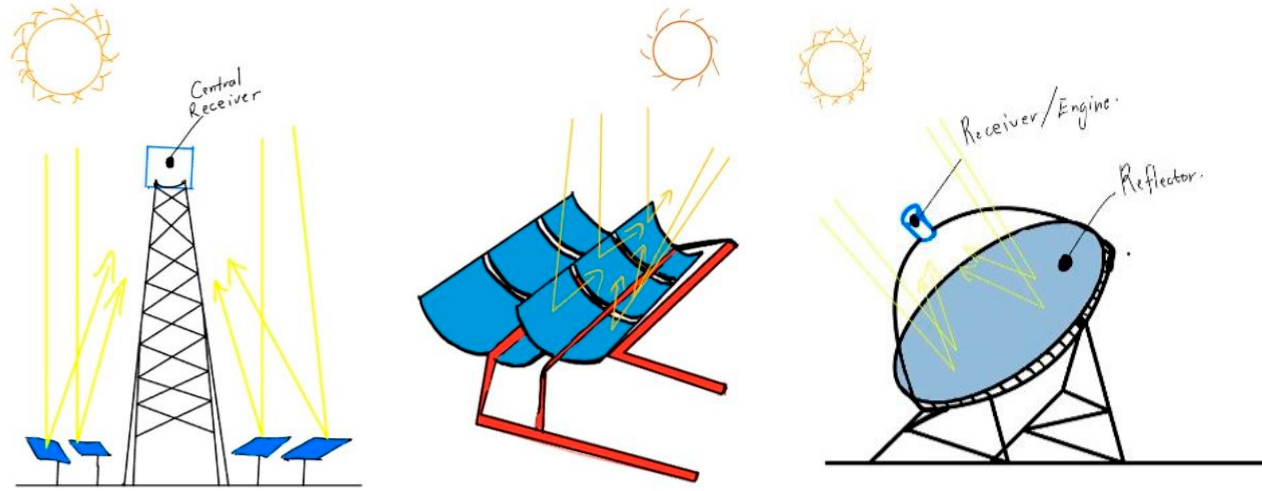
Figure 9. Parabolic trough and parabolic dish solar thermal energy collectors [17,18].